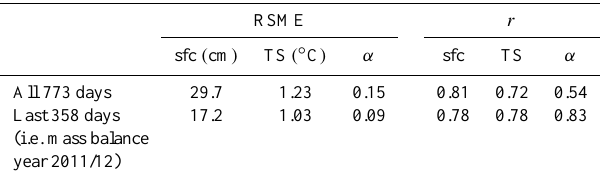
Table 3. Model uncertainties expressed as root-mean-square er- ror (RSME) and correlation coefficient ( r ) for surface height change (sfc), daily mean surface temperature (TS), and albedo ( α ) at the location of the